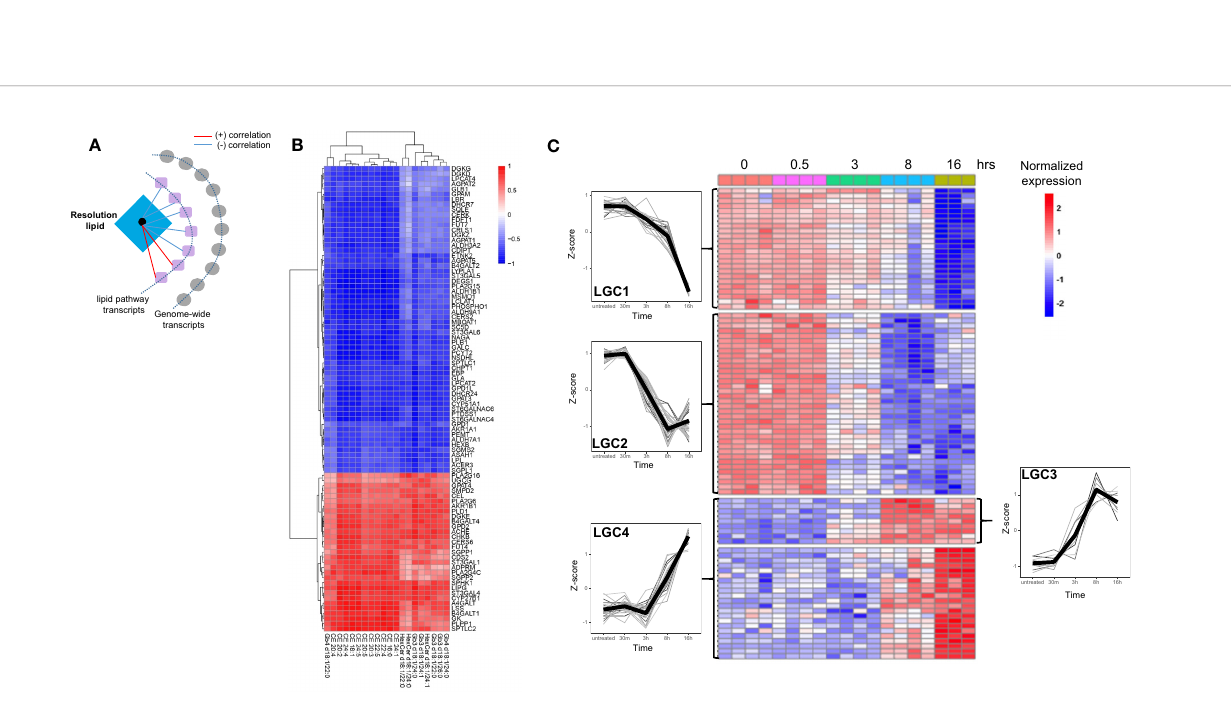
FIGURE 4 | The resolution phase lipids show strong correlation with lipid pathway genes. (A) Schematic for the correlation analysis. (B) Heatmap showing the correlation of the resolution lipids and lipid-pathway related genes. (C) Heatmap showing the kinetics of lipid-pathway-related genes throughout the LPS time- course. The lipid gene clusters (LGC) are separated by horizontal lines. At least n=3 samples for untreated (0), 30 min (0.5h), 3h, 8h and 16h LPS